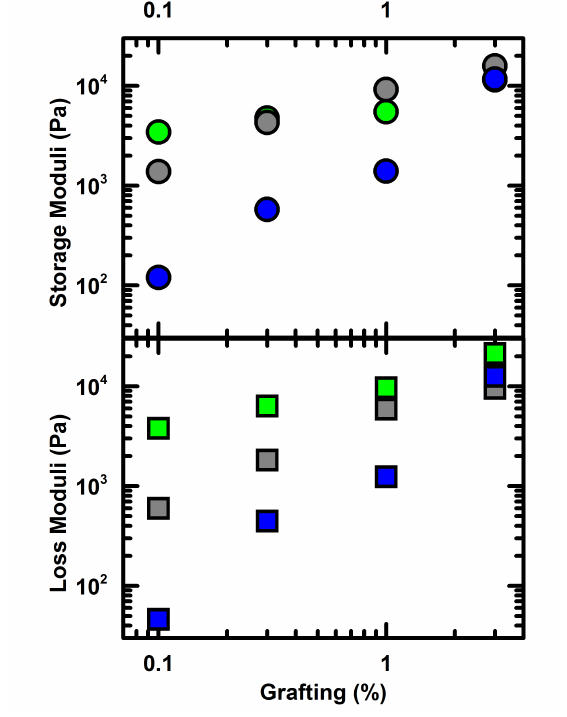
Figure 6. Storage and loss moduli after heating dispersions at φ = 0.28 with 30 mM NaCl to 45 ◦ C with green for DP = 10, gray for DP = 30, blue for DP = 100. All moduli are measured at 1 Hz and γ <